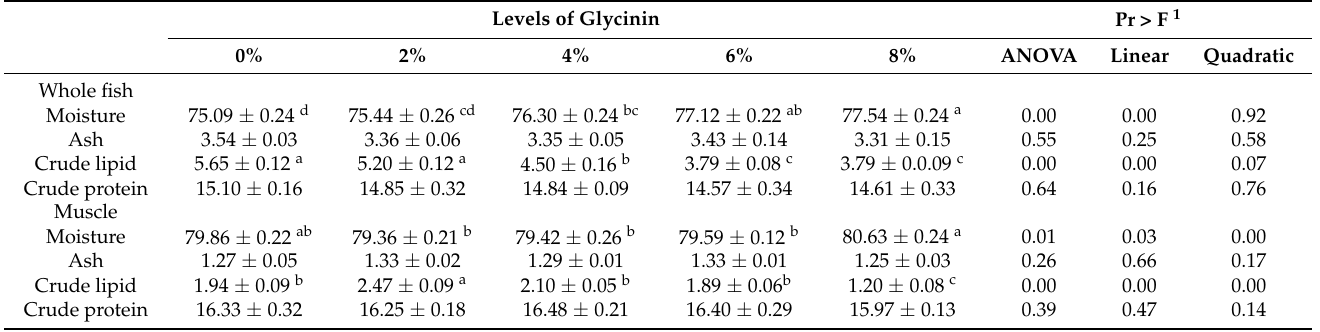
Table 2. Nutritional components in whole fish and muscle of hybrid yellow catfish (air-dry basis) (%). Levels of Glycinin Pr > F 1 ANOVA Linear Quadratic